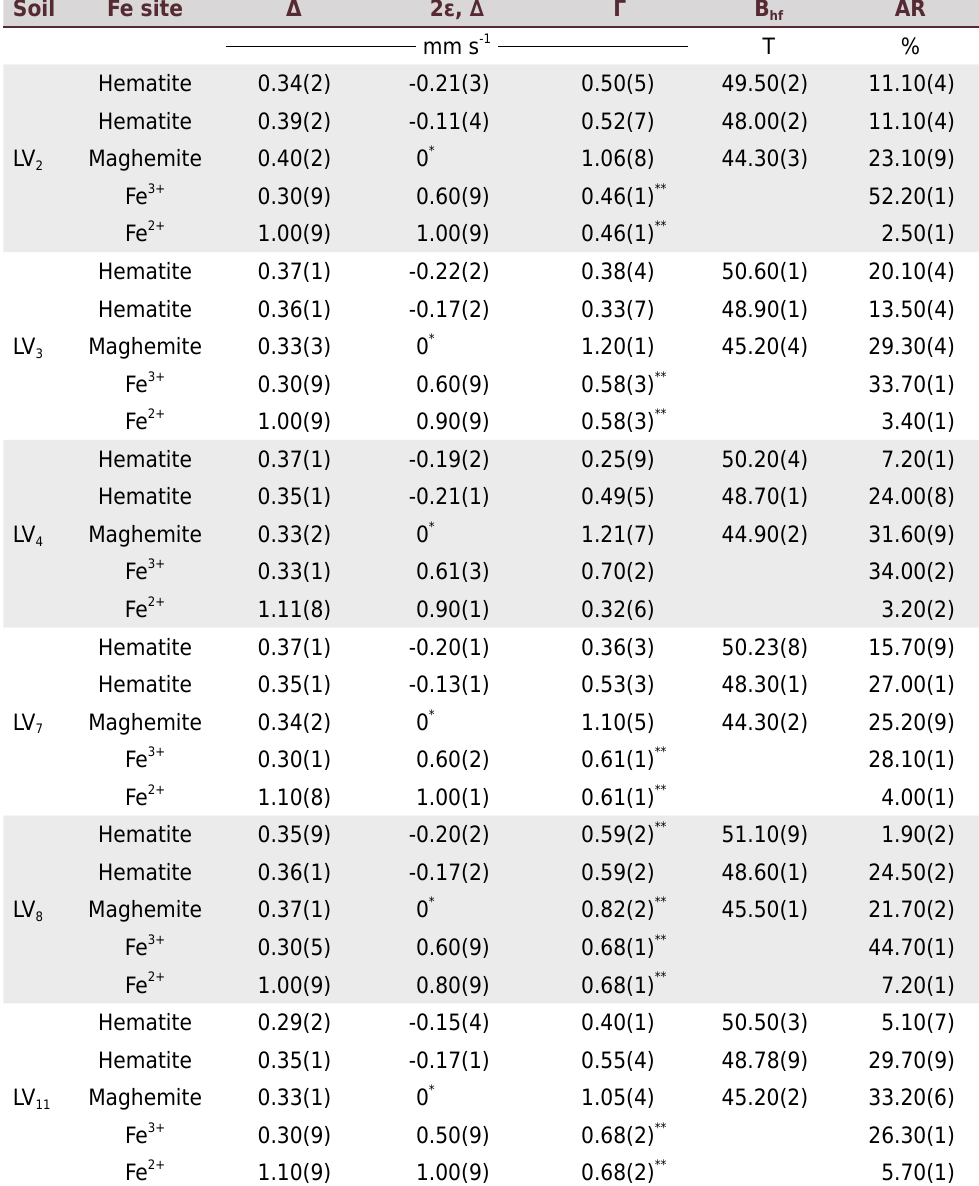
Table 4. 57 Fe hyperfine parameters at room temperature (~298 K) for clay fraction of selected soils LV 2 , LV 3 , LV 4 , LV 7 , LV 8 , and LV 11